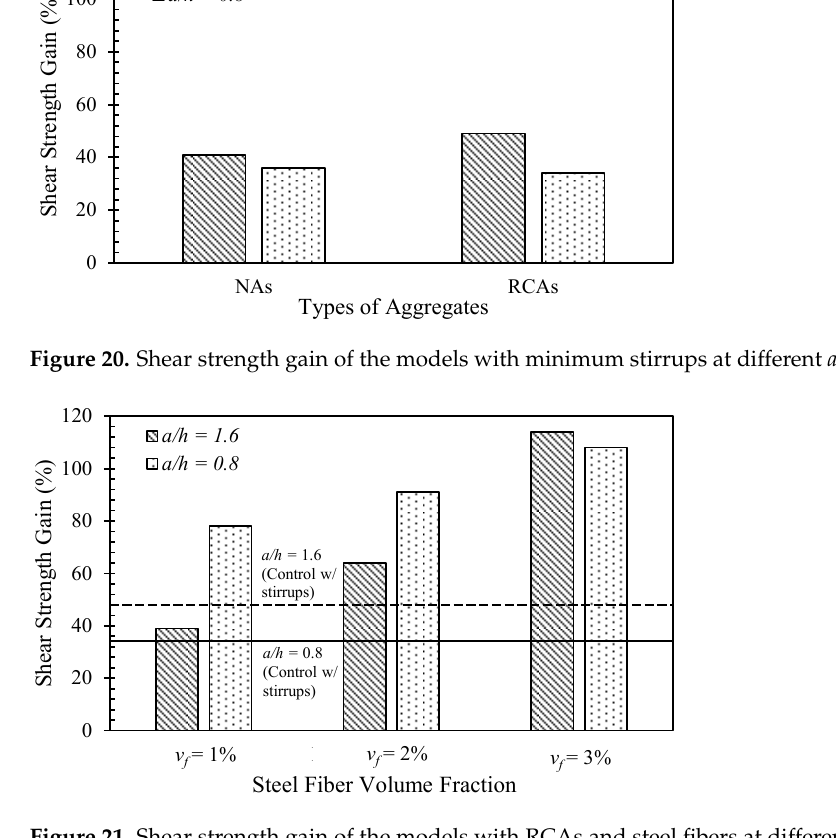
Figure 21. Shear strength gain of the models with RCAs and steel fibers at different a/h ratios.